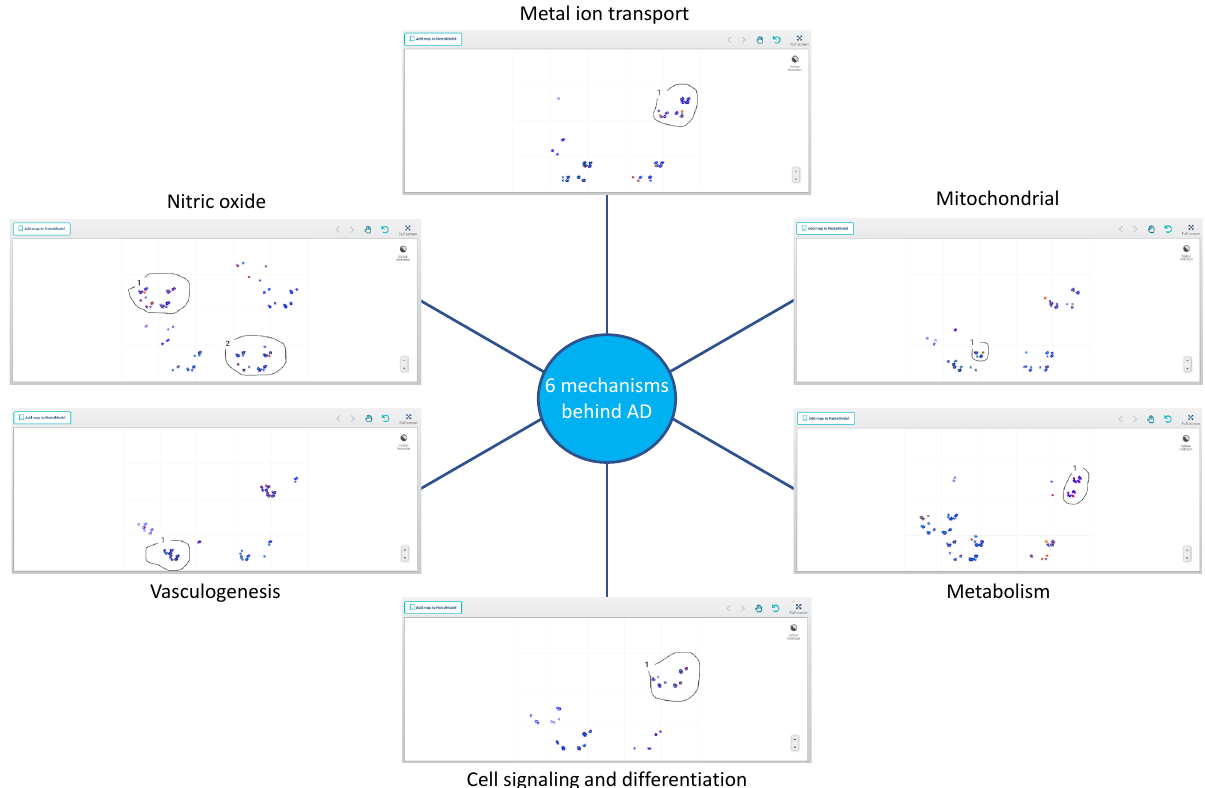
Figure 1. Perspective analytics for AD. Perspective analytics discovered a unique set of variables for each of the six different perspectives learned from an Alzheimer’s dataset. Within each set, there is a subgroup of subjects that are driven by the corresponding etiology Table 1. Perspective classes, characteristic genes, and defining traits of AD patients